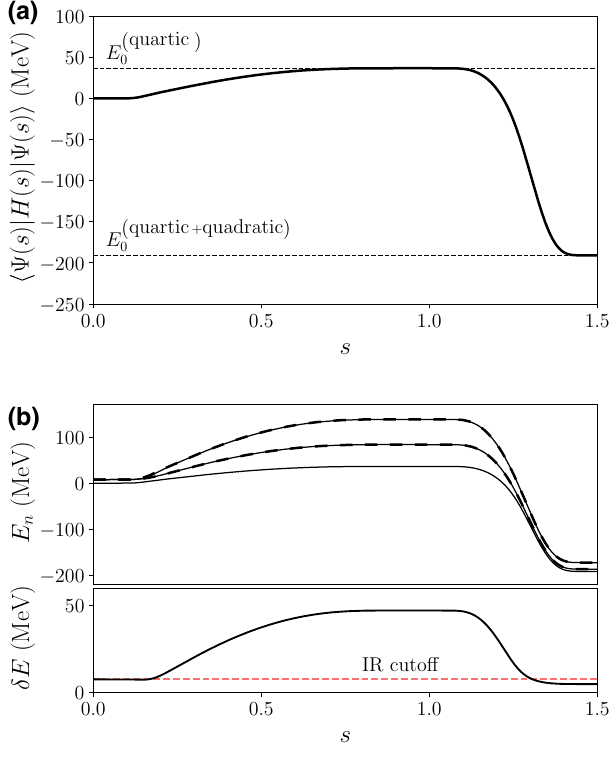
FIG. 8. (a) Instantaneous energy of the time-evolved wave function as a function of evolution time s . The dashed line labeled ( quartic ) shows where the ground-state energy of the sys- by E 0 tem with the quartic potential lies. The dashed line labeled by ( quartic + quadratic ) shows where the ground-state energy lies with E 0 the addition of the quadratic potential. (b) (Top) The energy spec- trum of the first five eigenstates of H ( s ) , and (bottom) energy gap between the ground state and the first excited state as functions of evolution time. The dashed red line is calculated from Eq. (25), yielding the infrared cutoff.